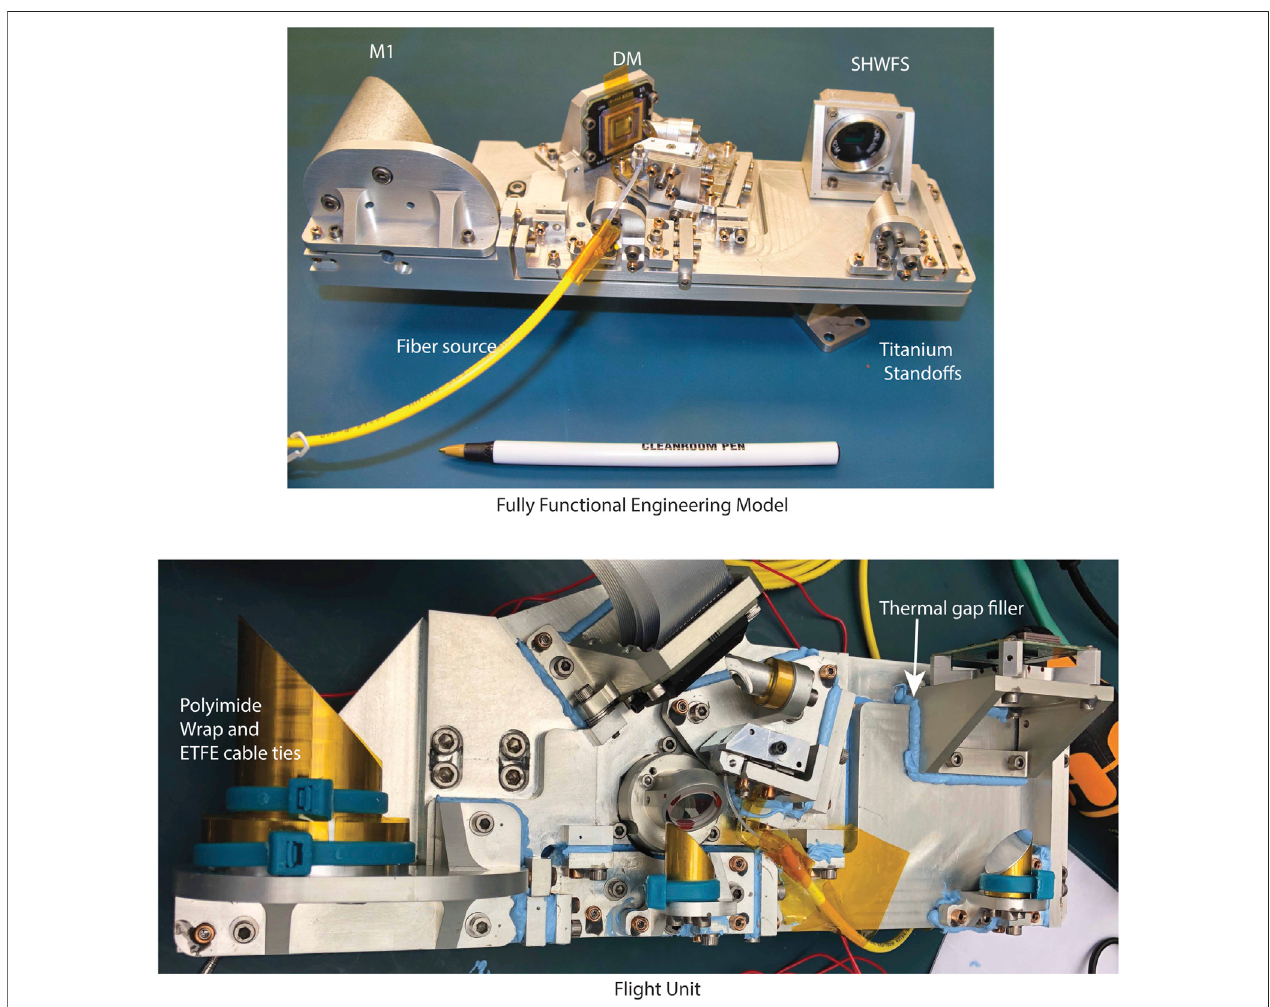
FIGURE 4 | Two fully function payload units were constructed to enable an iterative engineering approach. Top: A payload engineering model was built to fl ight speci fi cations to demonstrate optical performance, test wavefront sensing and control software, and to provide spare parts for fl ight. Bottom: assembled fl ight model. (The yellow Hytrel fi ber jacket protected the test fi ber and was not fl own).